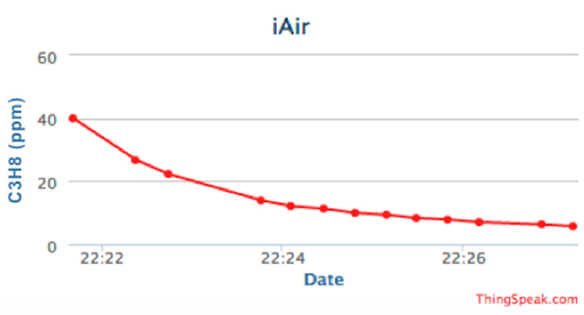
Figure 6. C 3 H 8 concentration (ppm); data obtained in the tests performed.